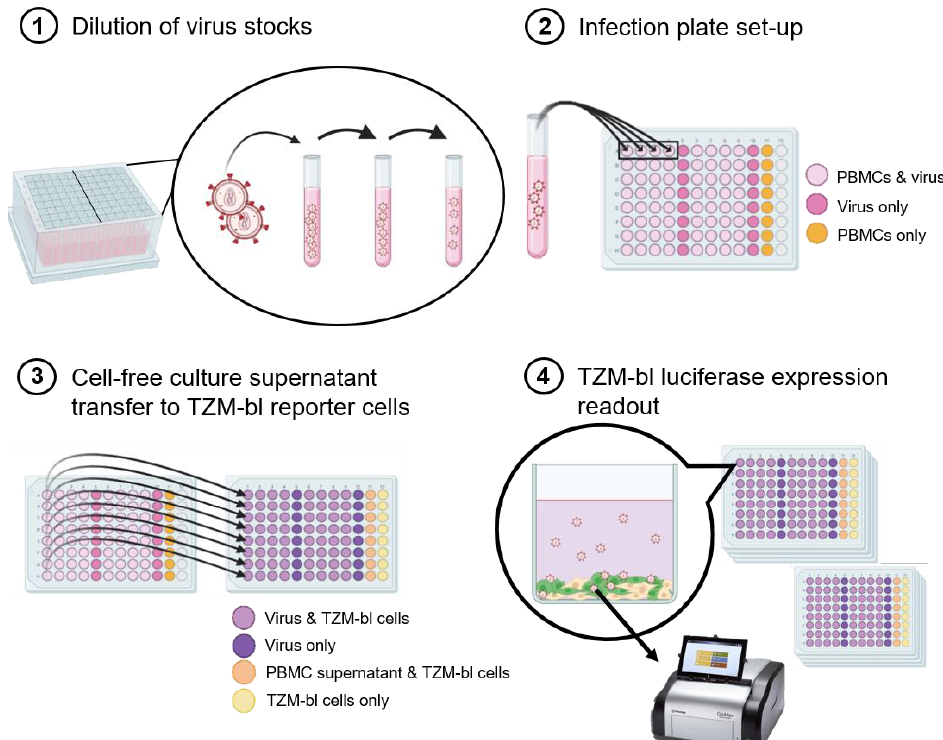
Figure 1. Workflow schematic of the high-throughput parallel replication capacity assay. ( 1 ) The virus stocks were added to the dilution tubes and diluted 1–5 times, depending on the TCID 50 /mL of the stock, in order to reach 2000 TCID 50 /mL. A total of 16 viruses could be diluted in one dilution box. ( 2 ) In quadruplicates, 100 μL of diluted virus was added to wells with 2 × 10 5 PBMCs (light pink wells) and to wells with only RPMI medium (dark pink wells). In addition, a row of 8 wells containing PBMCs only (no virus) was added as a control (orange wells). ( 3 ) Starting three days post infection, 10 μL of cell-free supernatant was transferred from the infection plates to plates containing 2 × 10 4 TZM-bl reporter cells per well (light purple wells: virus and TZM-bl reporter cells; dark purple wells: virus only; light orange wells: PBMC supernatant and TZM-bl reporter cells; light yellow wells: TZM-bl reporter cells only) at days 3, 4, 5, 6, and 7, post infection. The transfer was made each day starting at the same hour every day. ( 4 ) After 24 h incubation (starting at the same hour everyday), in batches of 4 plates per batch, the TZM-bl cells were lysed and the luciferase expression was measured.